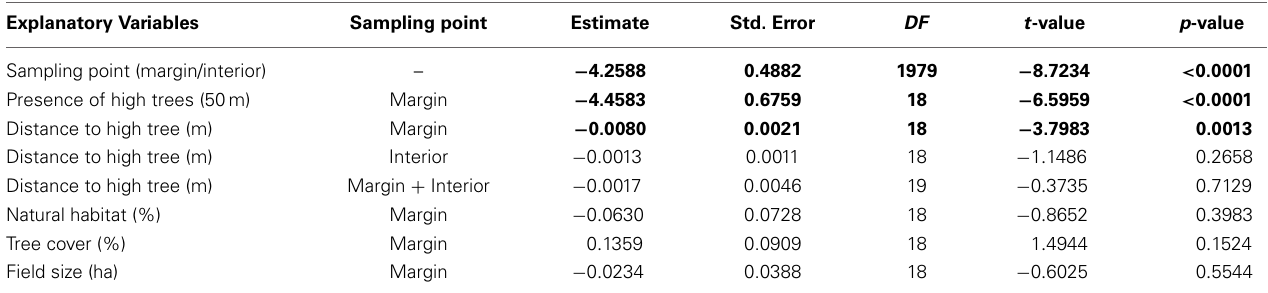
Table 2 | Effects on the percentage of seed predation of sunflower at the landscape scale in relation to the sampling point, presence of high trees (higher than 5m) within 50m to the sampling points, distance to the closest high tree or tree groups, natural habitat in % surrounding the sampling point in a 1km radius, tree cover in % surrounding the sampling point in a 1km radius and field size in ha. Explanatory Variables